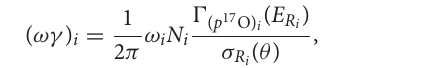
the 65 keV resonance and N 2 for the 183 keV resonance) with their statistical errors. In case of narrow resonance, the N i peak values are connected to the resonance strengths ( ωγ ) i (Rolfs and Rodney, 1988) of the 18 F levels, which are the key parameters to evaluate the reaction rate for astrophysical applications.